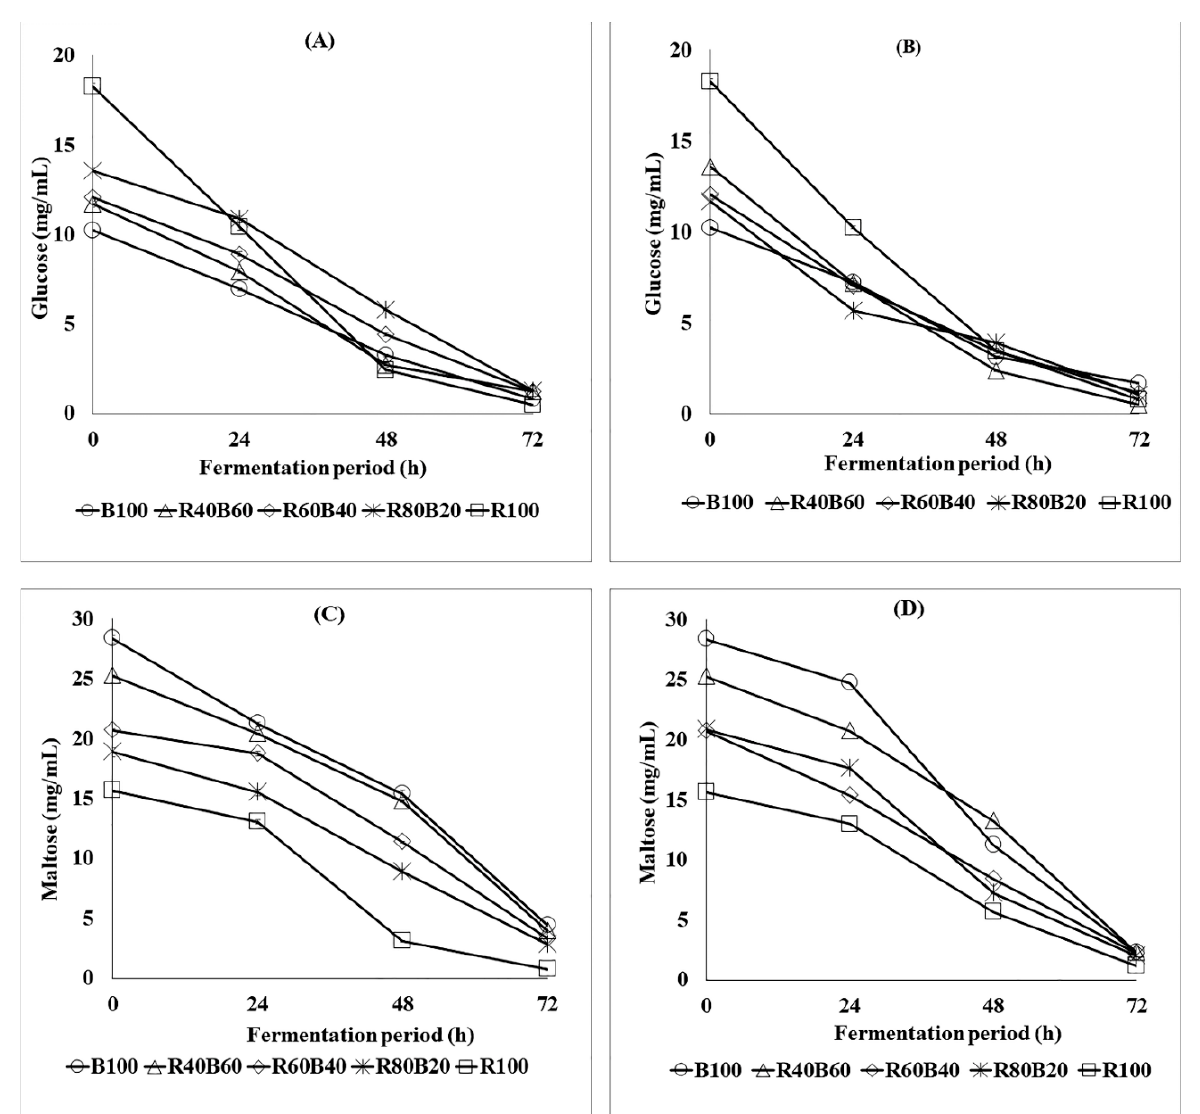
Figure 1. Dynamic of glucose and maltose during 72 h fermentation of composite wort: glucose metabolism by POF − ( A ) and POF + ( B ); maltose metabolism by POF − ( C ) and POF + ( D ). BRY 97 ( S. cerevisiae ), POF − ; and Belle Saison ( S. cerevisiae var. diastaticus ), POF + .